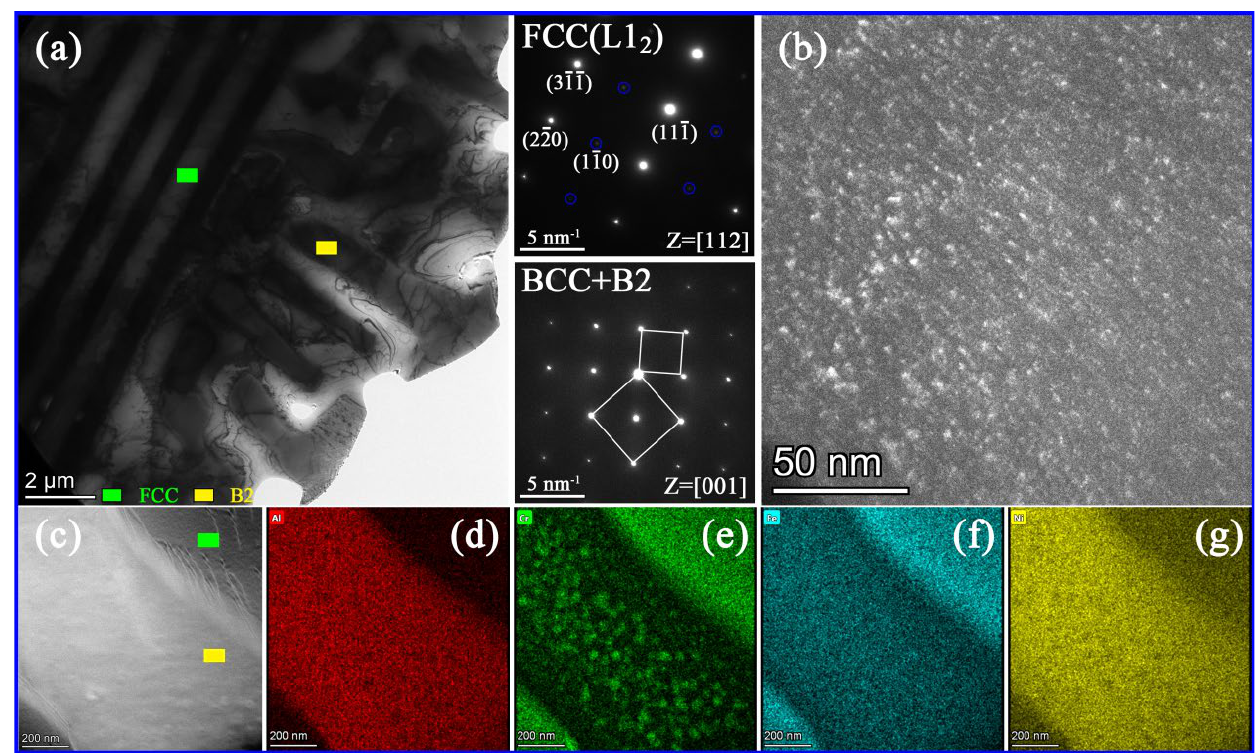
Figure 5. TEM analysis results of the AlCrFe 1.46 Ni 2.5 alloy. ( a ) Bright-field image; ( b ) Dark field image of the FCC phase; ( c ) HAADF–STEM image; ( d – g ) Elemental distribution EDS maps.